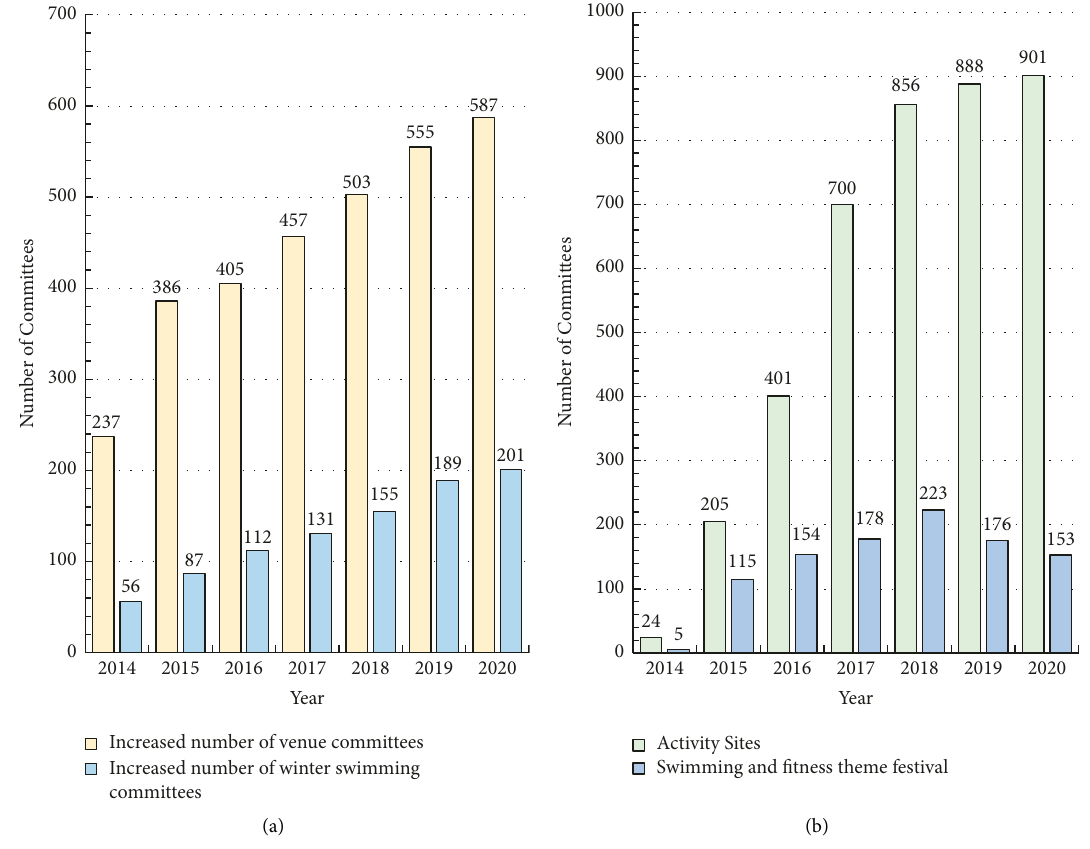
Figure 10: Growth trend of activity sites and theme festivals for “national swimming and fitness week”